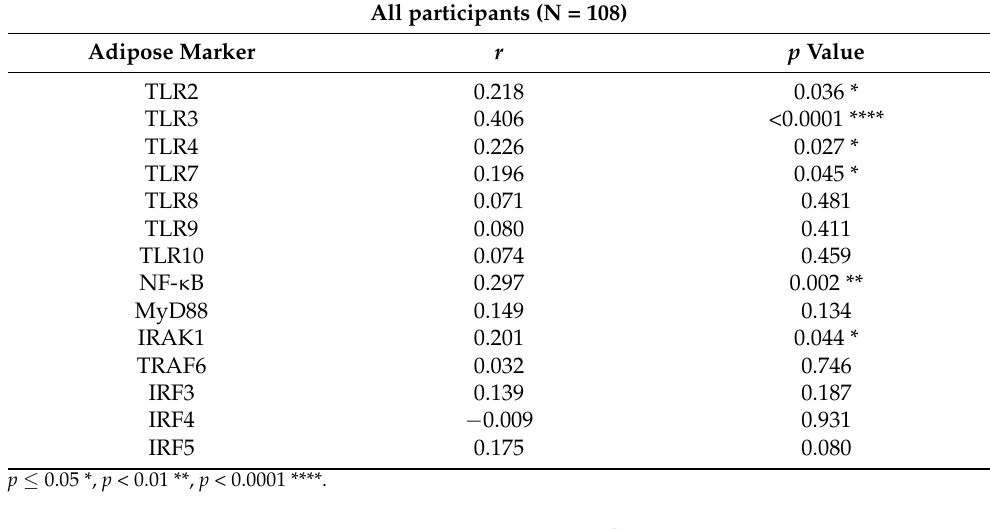
Table 2. Spearman’s correlation analysis of adipose gene expression of SRA1 with TLRs, their signaling mediators, and IRFs in the total study population.